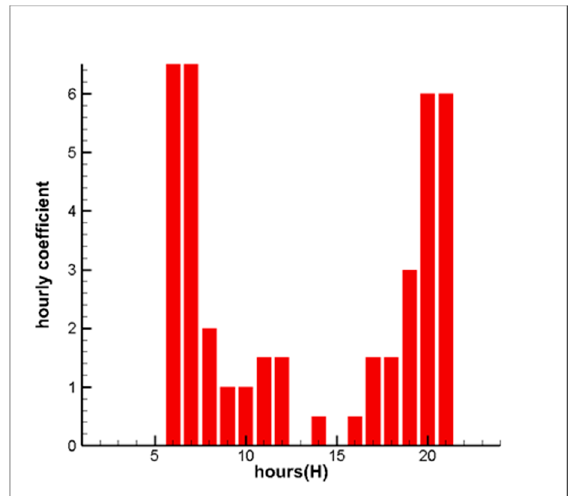
Figure 5. The daily profile of domestic hot water use.